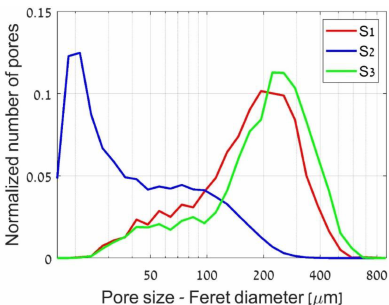
Figure 10. Statistics of the pore sizes calculated by image analysis for three sandstone samples: S1, S2 and S3. Number of pores anal- ysed: S1 – 3500, S2 – 45000, S3 – 3500. The CT data sets used